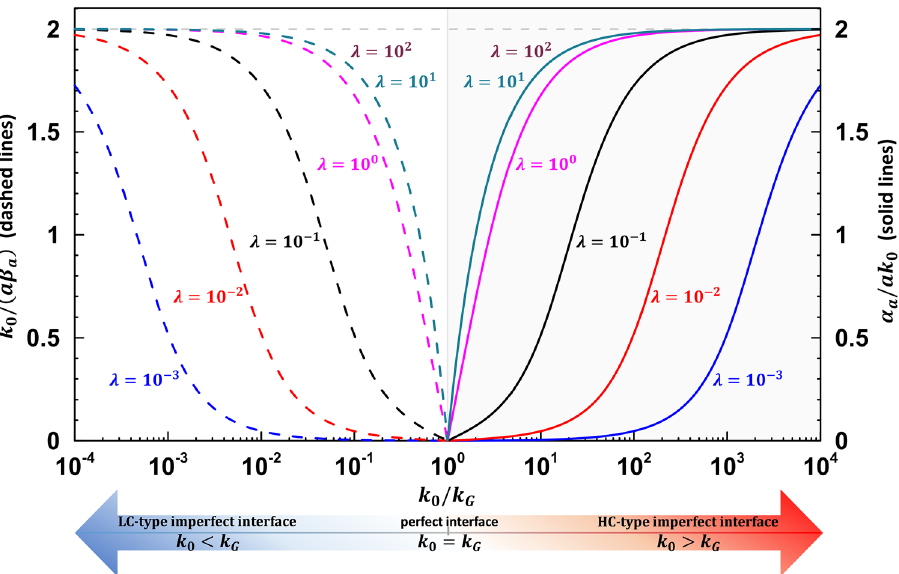
Figure 2. Numerical illustrations of the geometric and material parameters that fulfill the thermal invisibility conditions (3) and (5) for c = 1/4. The horizontal axis is k 0 / k G , expressed in logarithmic scale. The left panel, corresponding to the range of k 0 / k G < 10 0 , will invoke a LC-type interface parameter k 0 /aβ a . Different curves (dashed lines) correspond to different values of λ . The right panel, corresponding to the range of k 0 /k G > 10 0 , will involve a HC-type interface parameter α a / ak 0 . Different curves (solid lines) corresponds to different values of λ and the vertical axis is marked on the right-side. Note that the curve λ = 10 0 corresponds to an isotropic material in Region II in which k r = k θ